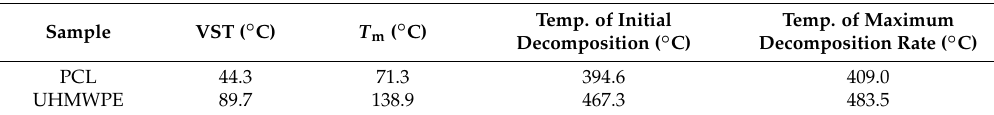
Table 3. Thermal properties of PCL and